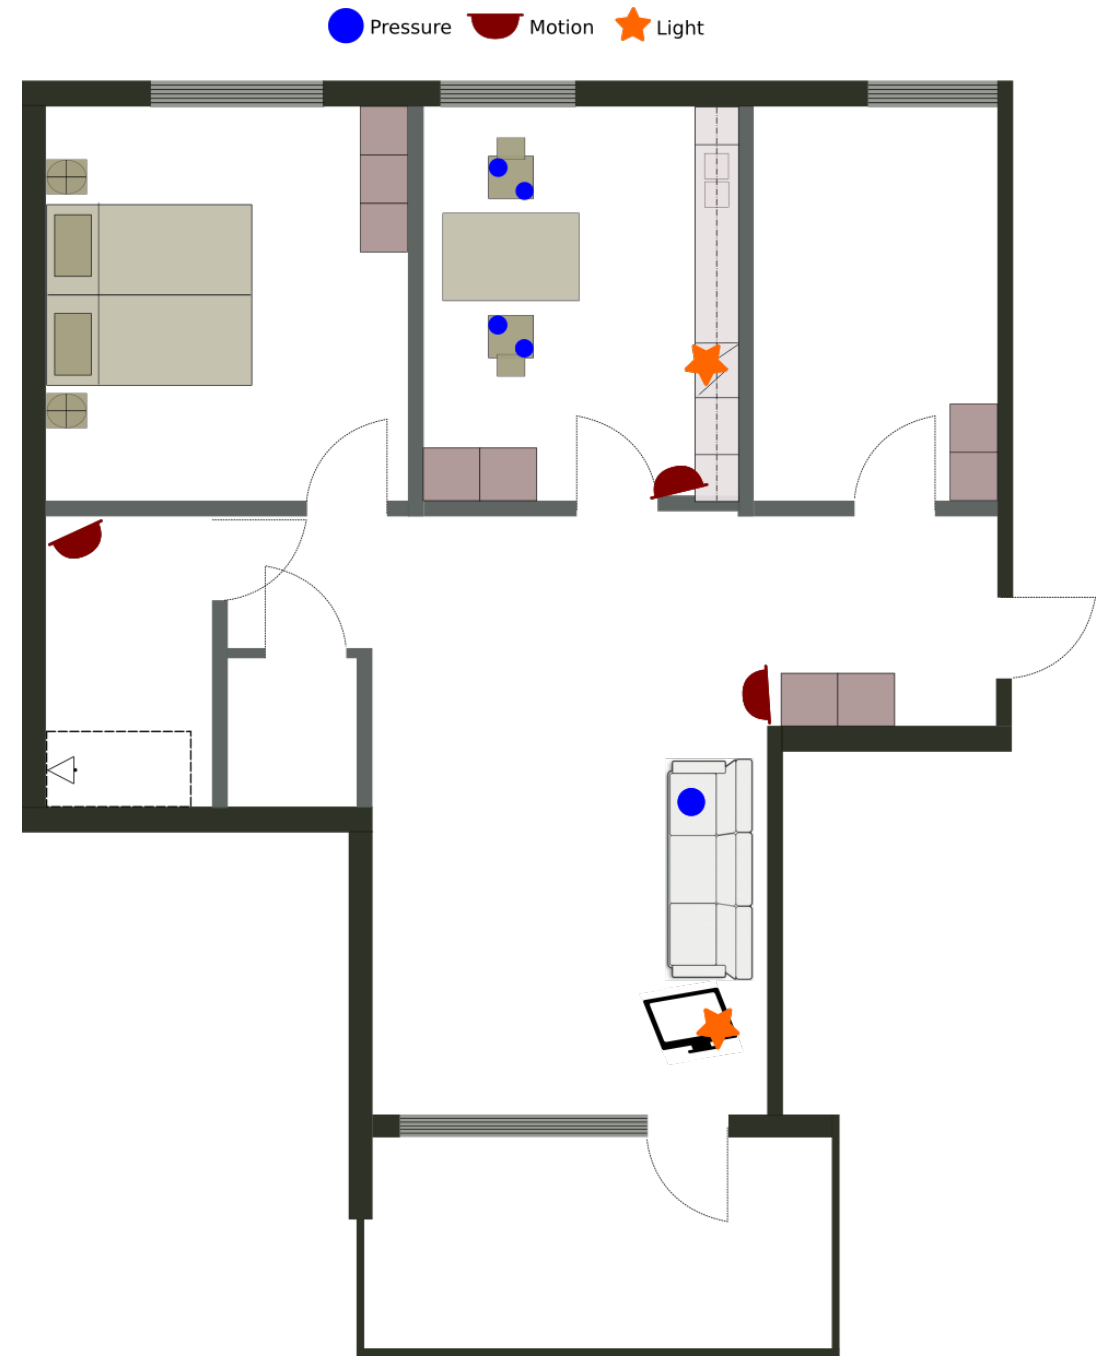
Figure 9. The Ängen smart apartment and sensors used for the person counting data